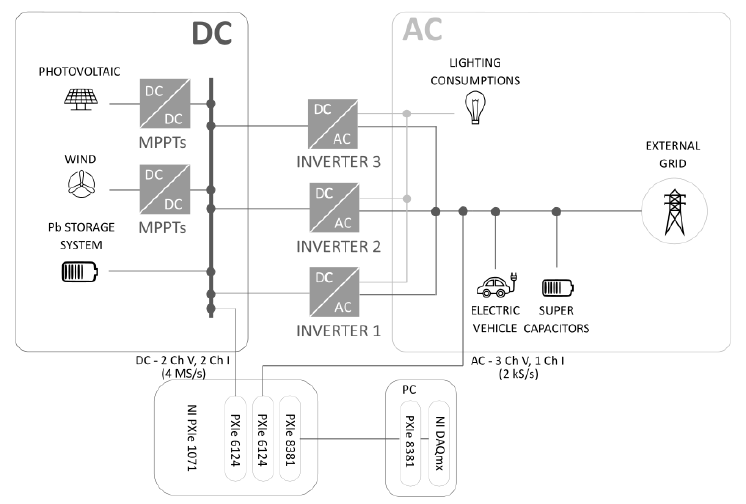
Figure 1. Micro-grid outline and digitization